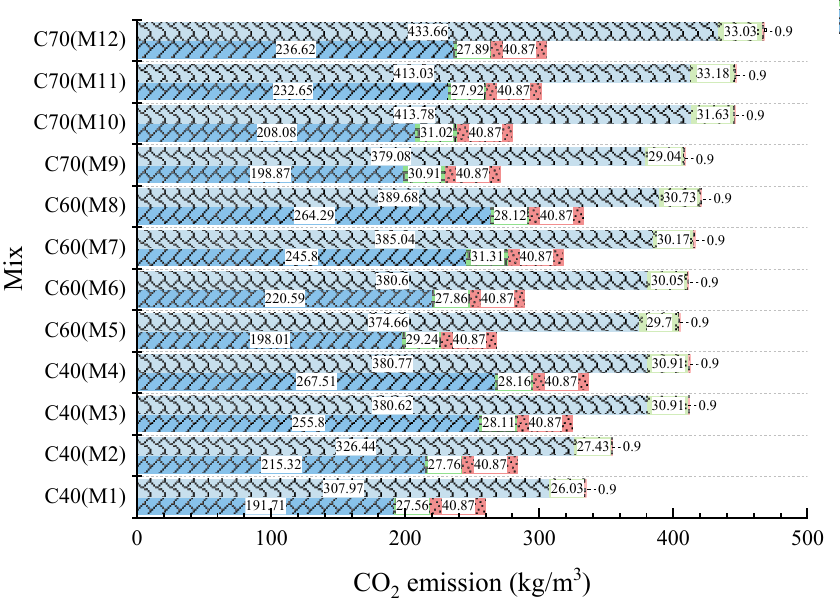
Figure 2. Distribution of CO 2 emission of different phases. Notes: Csc: Carbon emission of raw materials production. Cys: Carbon emission of transportation. Cc: Carbon emission of concrete production.